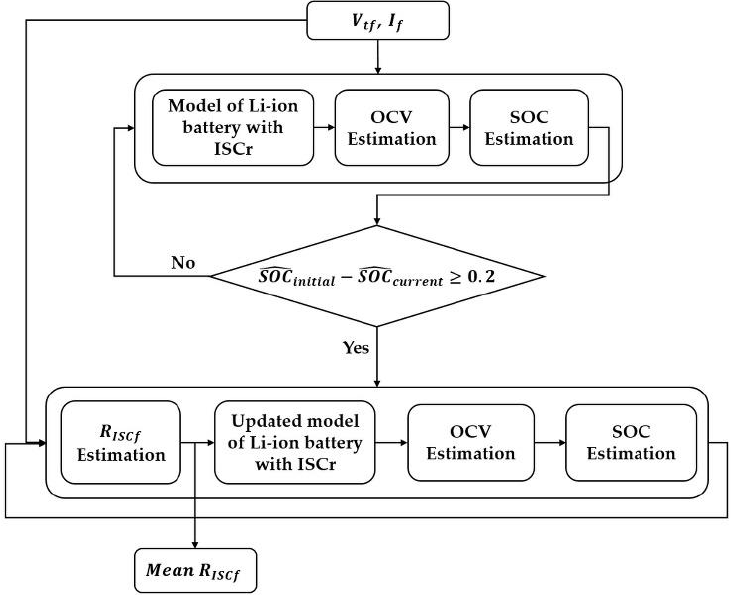
Figure 1. The scheme of the switching model method.